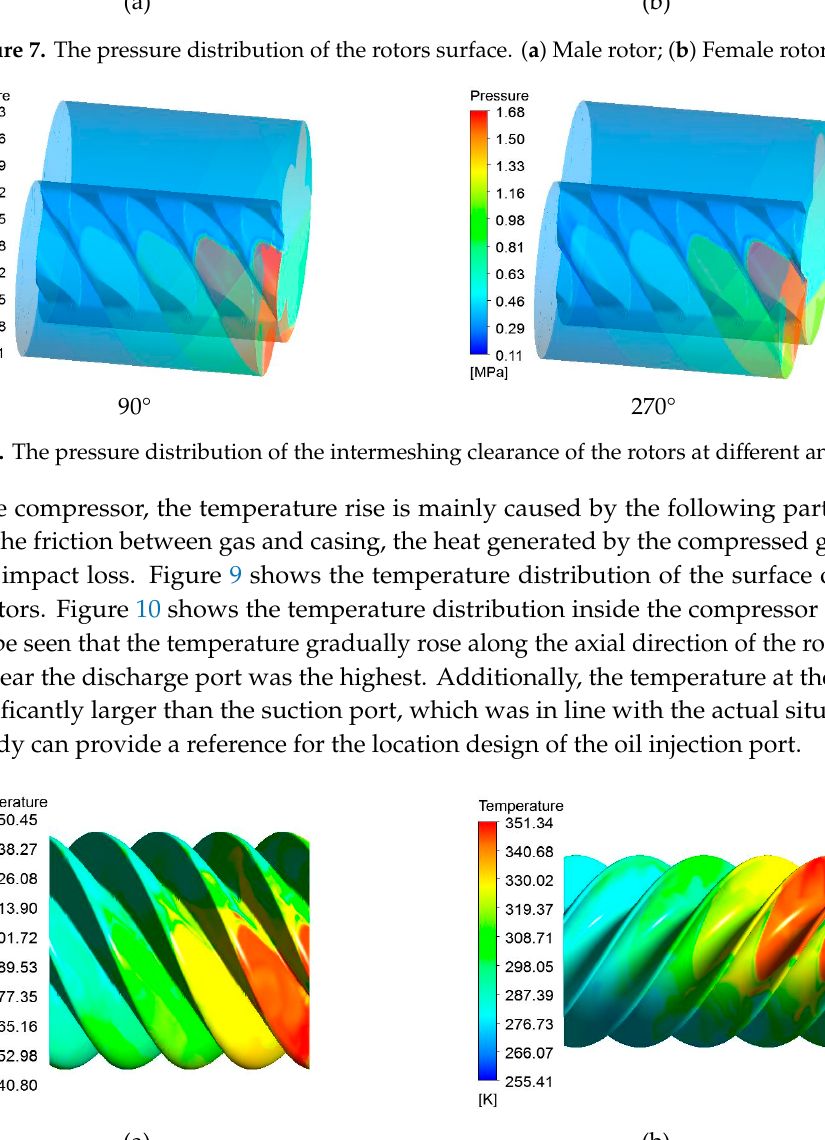
Figure 9. The temperature distribution of the surface of the male and female rotors: ( a ) male rotor; ( b ) female rotor.